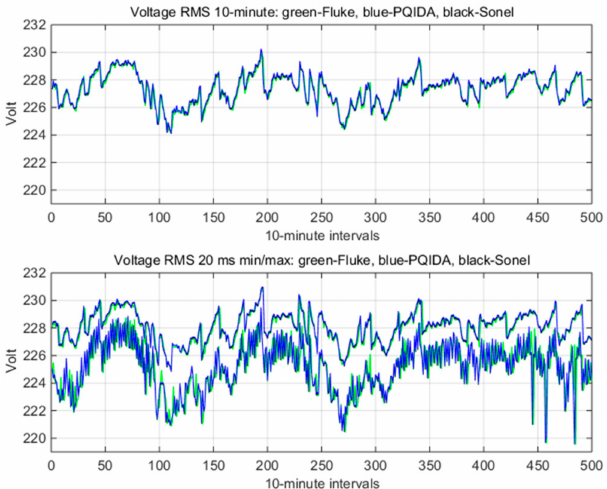
Figure 9. Changes in the RMS voltage (phase L1): the top graph—aggregated 10-min RMS values; the bottom graph—min/max 20 ms RMS